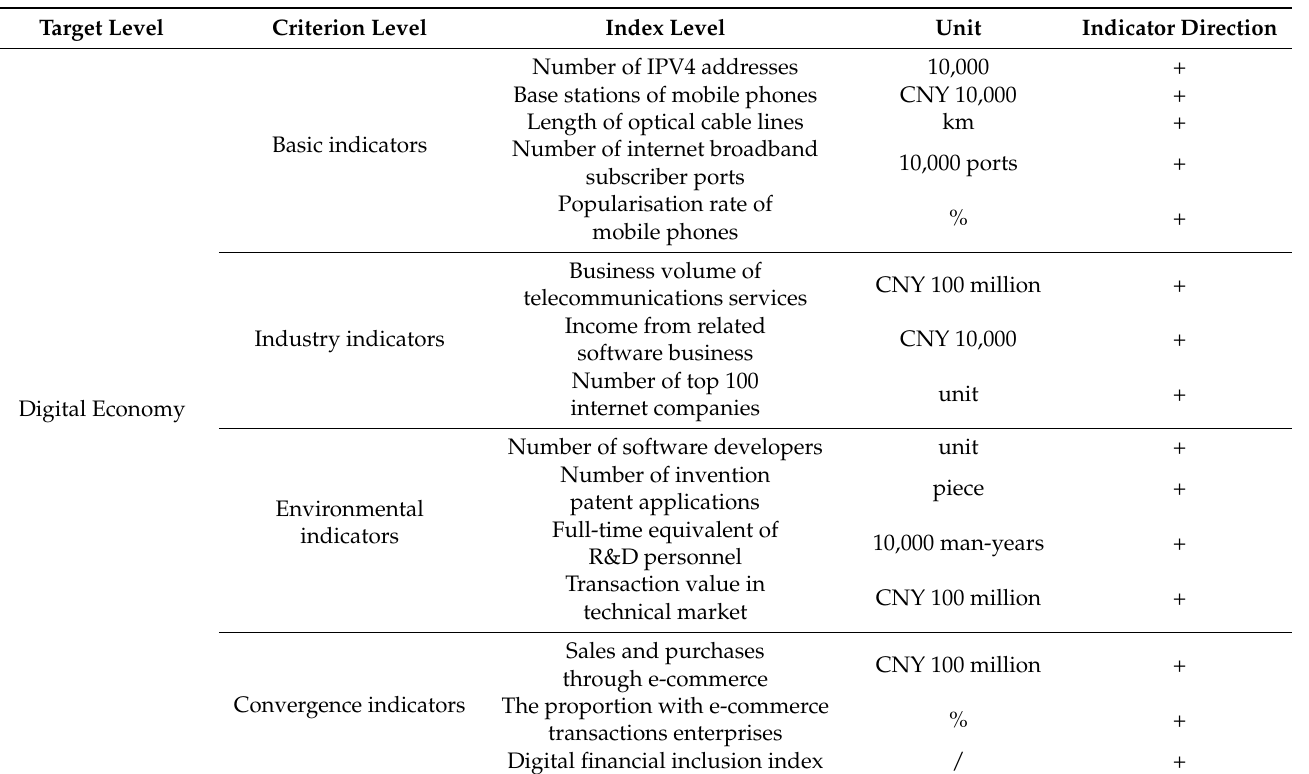
Table 1. Evaluation system of the digital